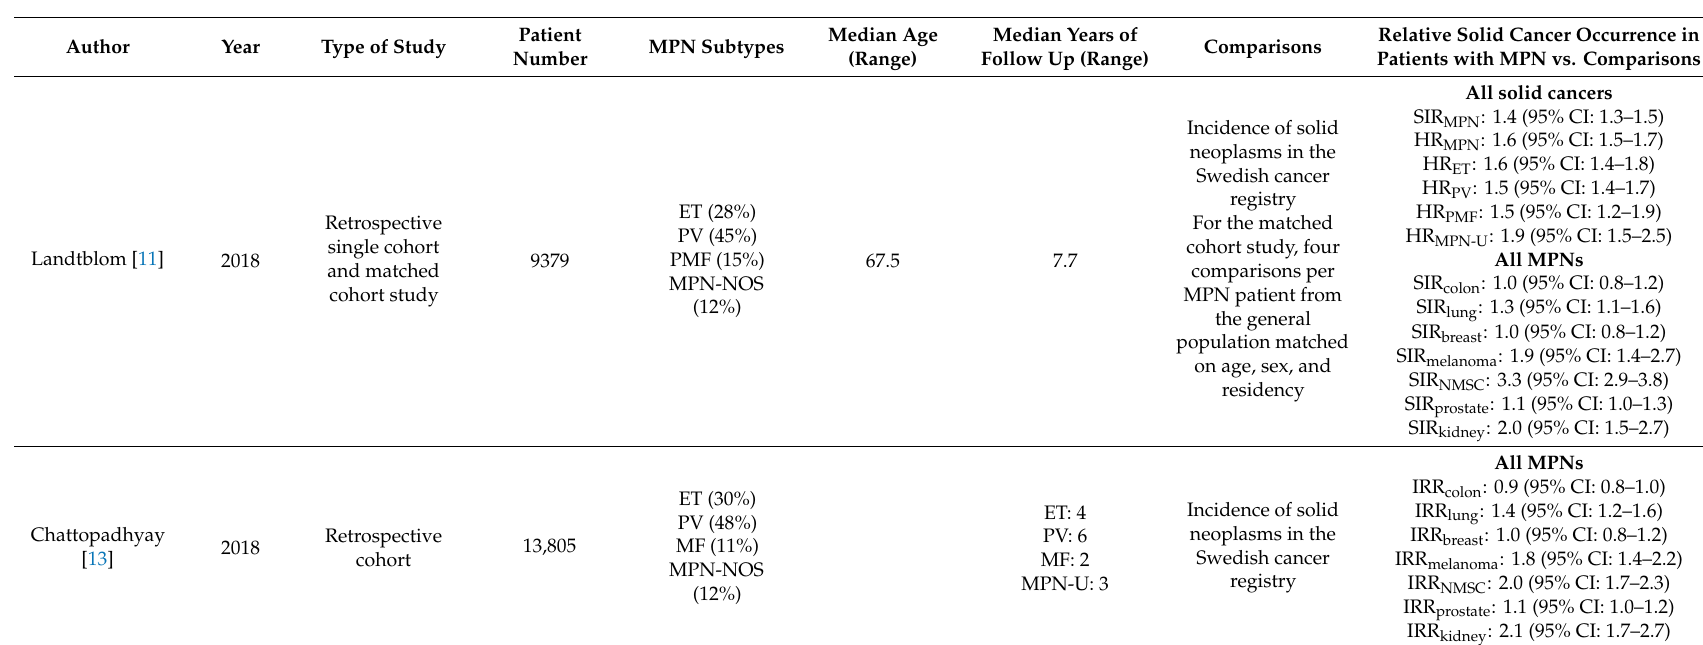
hazard ratio for a solid cancer diagnosis in patients with MPN compared to age, sex, and residency-matched comparisons from the general population. SEER: surveillance, epidemiology, and end